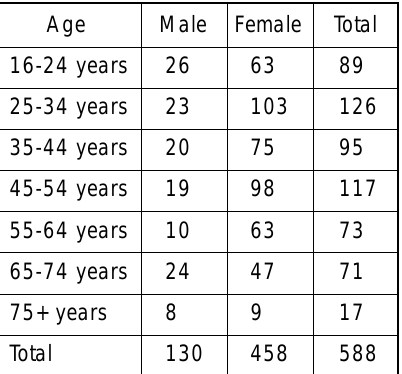
Table 1: Table of gender and age of